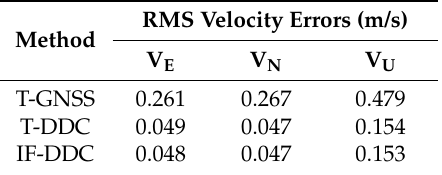
Table 8. RMS velocity error statistics of the dynamic test.